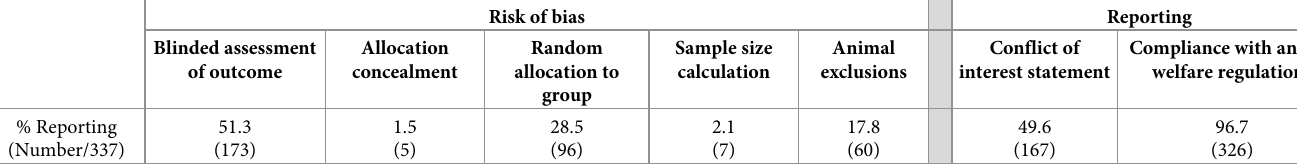
Table 3. Reporting of measures to reduce the risk of bias and reporting.